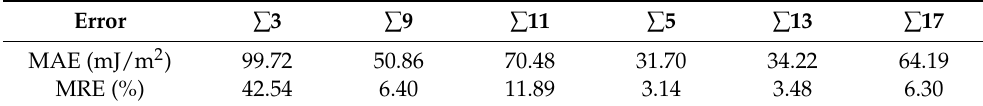
Table 1. MAE and MRE of Cu GB energy predictions. Note that this table lists the prediction for PCF comb computed for CNA-based GB atom selection and ζ is taken as 0.5.